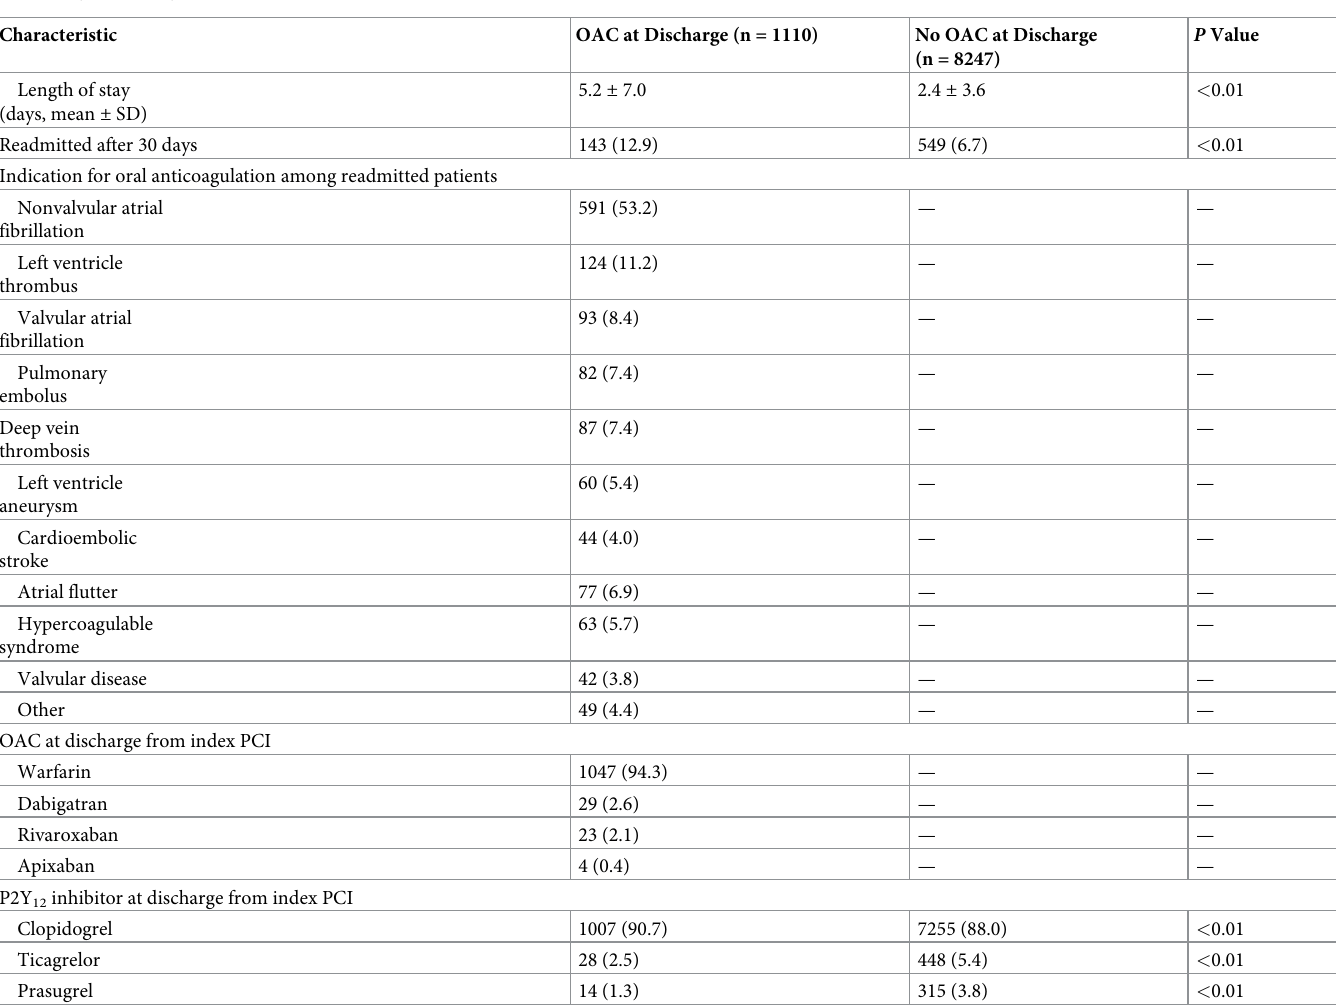
on OACs (6.0%, p < 0.01). Among OAC patients, gastrointestinal hemorrhage was the most frequent cause of bleeding (85.0%). The majority of bleeds were classified as BARC 3a (55.0%), followed by type 2 (25.0%) and 3b (20.0%) in the OAC population. No fatal bleeding events occurred among all patients. Details regarding the BARC classification for all bleeding-related readmissions are shown in the Supporting Information (S3 Table). During rehospitalization, patients discharged on OACs relative to those not on OACs experienced a higher unadjusted rate of mortality (6.3% vs 1.8%, respectively, p < 0.01) and longer lengths of stay (6.4 ± 7.1 days vs 4.9 ± 6.8 days, p = 0.02). Among readmitted patients on OACs, there were no significant dif- ferences in outcomes observed after stratifying patients by chronic anticoagulant status